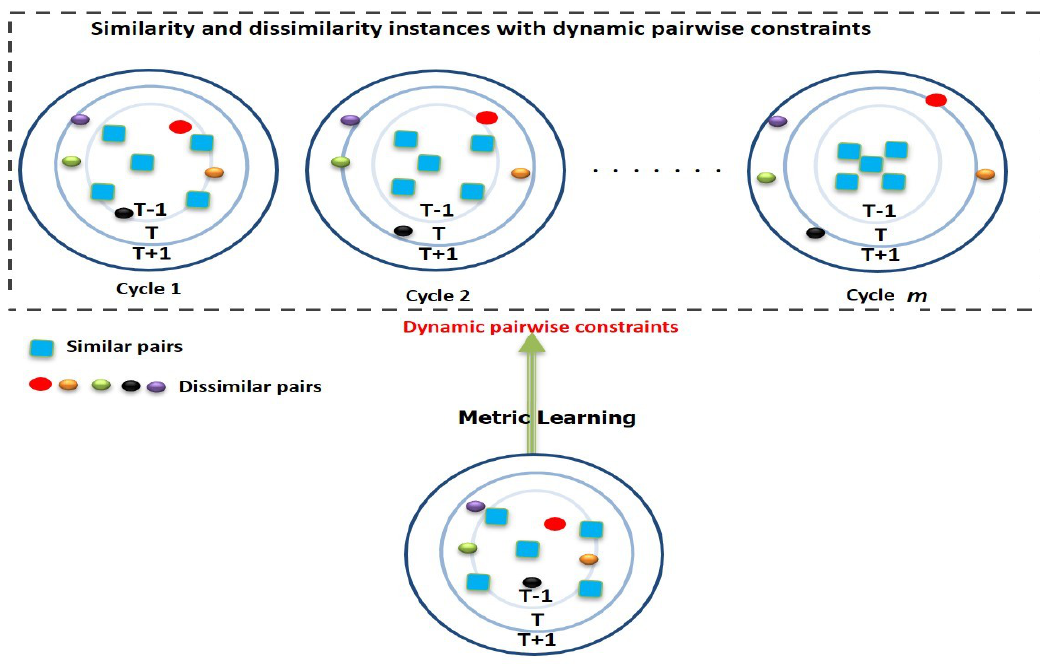
Figure 1. Diagram of the dynamic pairwise constraints. It shows the convergence of similar pairs (squares) and divergence of dissimilar pairs (circles) by updating pairwise constraints.